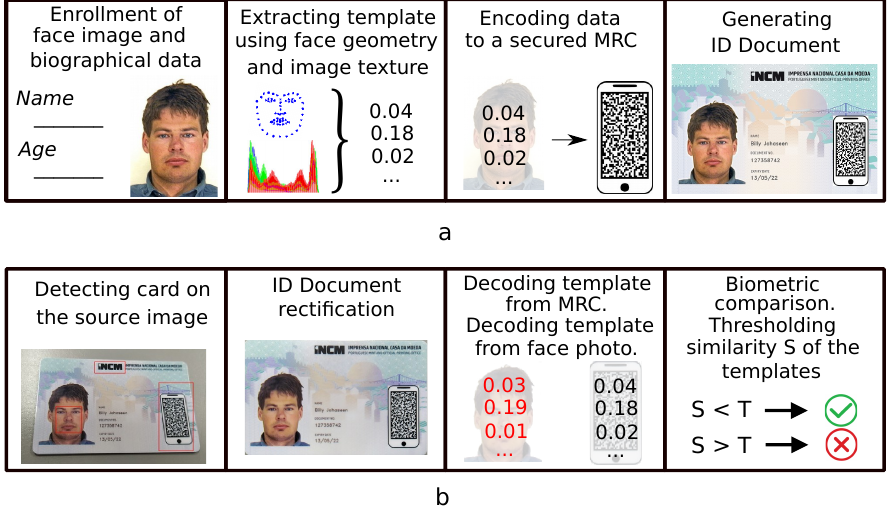
Figure 1. Pipeline of the proposed system: ( a ) ID card generating; and ( b ) ID card